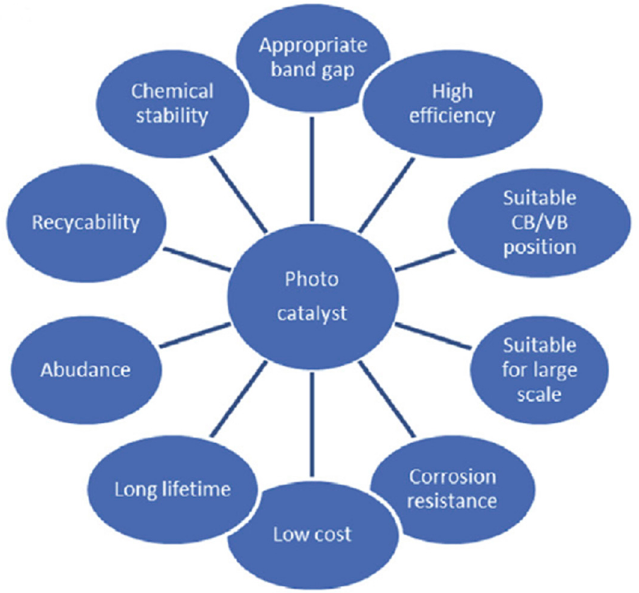
Figure 2. Properties of photocatalyst important for photocatalysis. Reproduced with permission from Elsevier [4].